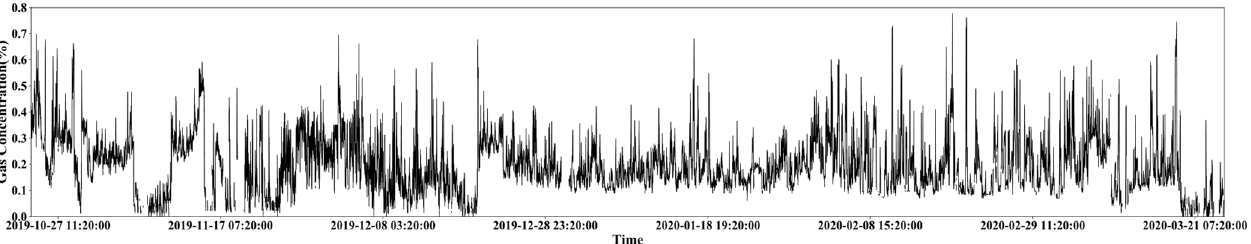
Figure A4. Variation trend of gas concentration in D5 data set.